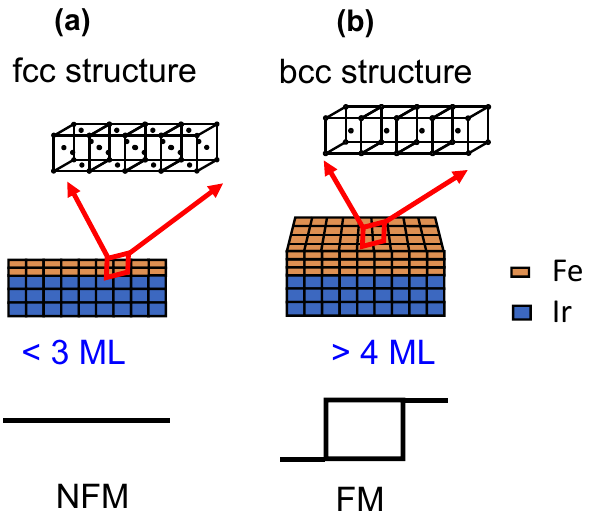
Figure 4. A schematic plot showing the SDPT model for describing the structural evolution and related magnetic phase transition for Fe/Ir(111) with thickness ( a ) < 3 ML, ( b ) > 4